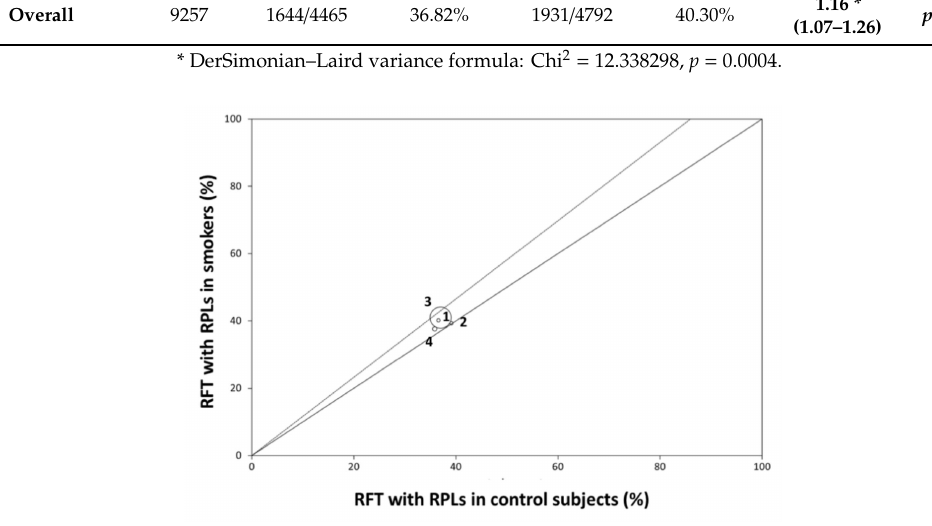
Figure 2. L’Abb é plot presenting the prevalence of root filled teeth (RFT) with radiolucent periapical lesions (RPLs) in each of the four studies in smoker patients and healthy controls. Circles of di ff erent sizes represent the weights of the sample of each study (1) Segura-Egea et al. (2008) [24];